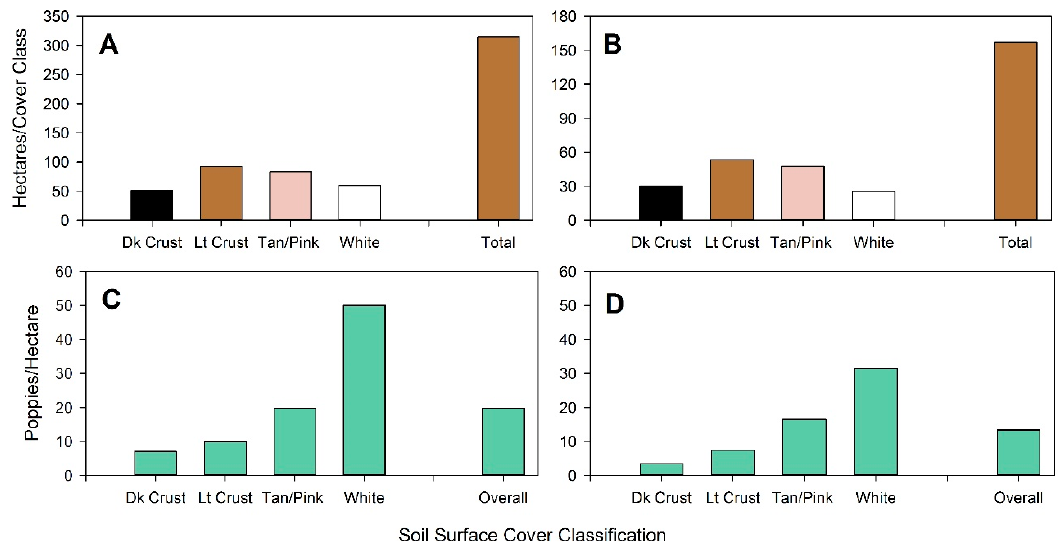
Figure 5. Area covered by each of the four soil surface cover classes and total area at: ( A ) White Dome and ( B ) Tonaquint, and poppy densities in each of the four cover classes and overall at: ( C ) White Dome and ( D ) Tonaquint. Analysis was based on marked plants. See Table 2 for statistical analysis.